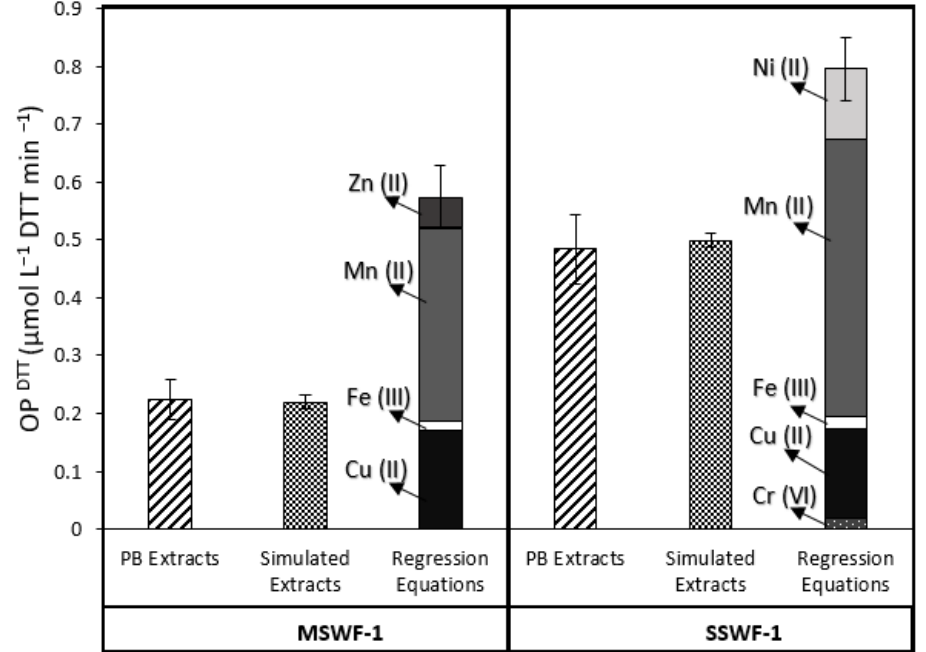
Figure 2. Blank-corrected rates of DTT loss (OP DTT ) in welding fume (WF) extracts of mild steel (MSWF) and stainless steel (SSWF) measured experimentally either on PB extracts (PB extracts; 6 replicates) or on reconstituted mixtures (Simulated Extracts; 3 replicates) and calculated theoretically via regression equations of the DTT loss rate as a function of the concentration of pure metals (Table 2).